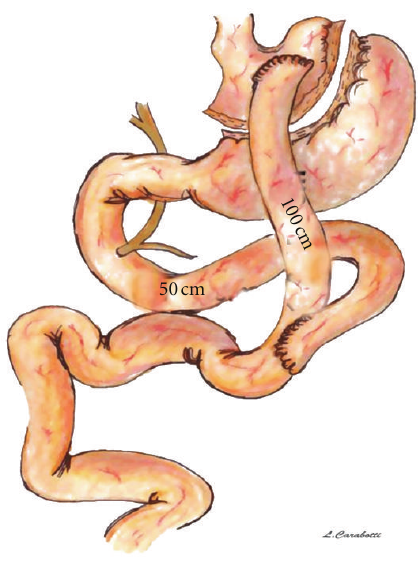
Figure 1: Adjustable gastric banding. Figure 2: Roux-en-Y gastric